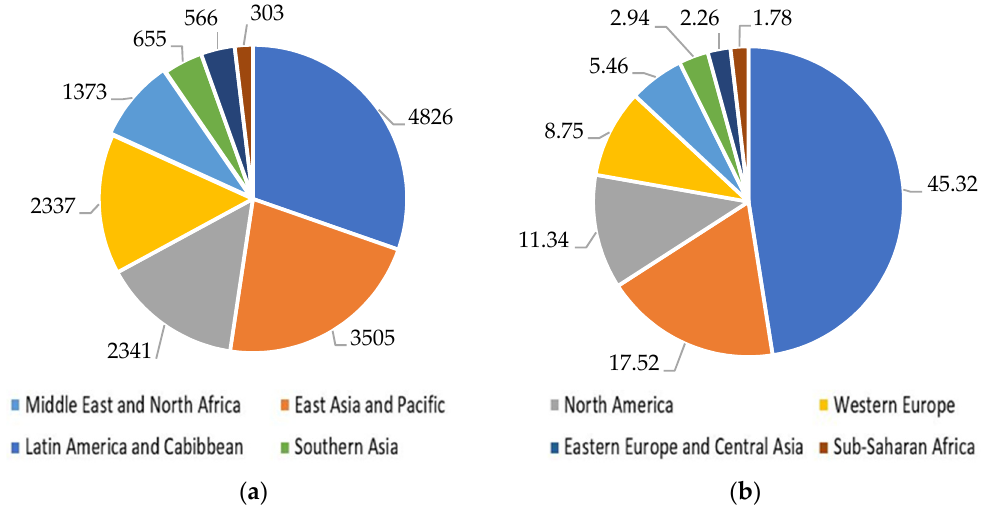
Figure 1. Number and capacity of desalination plants by region in 2019: ( a ) number of desalination plants; ( b ) desalination capacity (million m 3 /day), with data from [9].